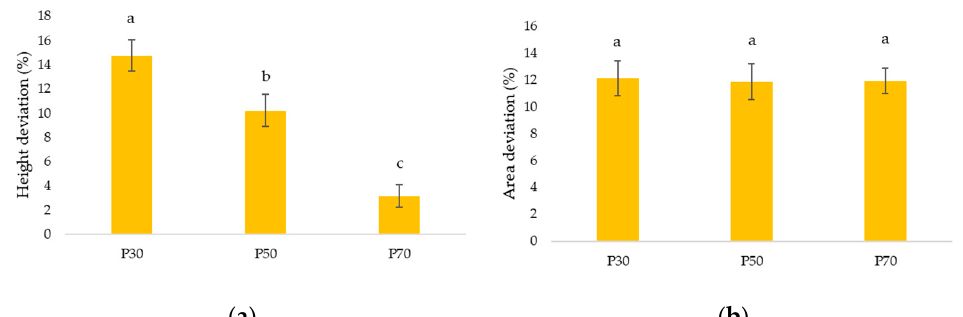
Figure 3. ( a ) Deviations of the height parameter of the samples. ( b ) Deviations of the area parameter of the sample (P30: Printed sample 30% pulp; P50: Printed sample 50% pulp; 70: Printed sample 70% pulp). Letters (a–c) indicate homogeneous groups according to ANOVA ( p < 0.05).